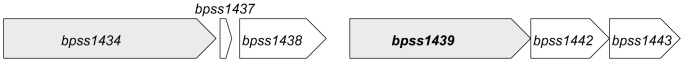
The arrangement of the bpss1439 operon.The bpss1439 gene is located in an operon with two downstream genes, bpss1442 and bpss1443; both which encode hypothetical proteins of no significant database hits. The closest orthologue to bpss1439 is the upstream gene (bpss1434) encoding another unstudied predicted TAA.